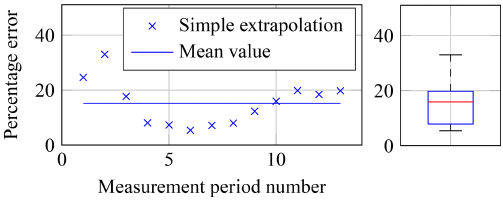
Figure 13. Percentage errors of predicted yearly damage values us- ing a simple extrapolation method compared to real yearly dam- age values. Prediction from a year to a second year for 13 different years. Box plot shows summary